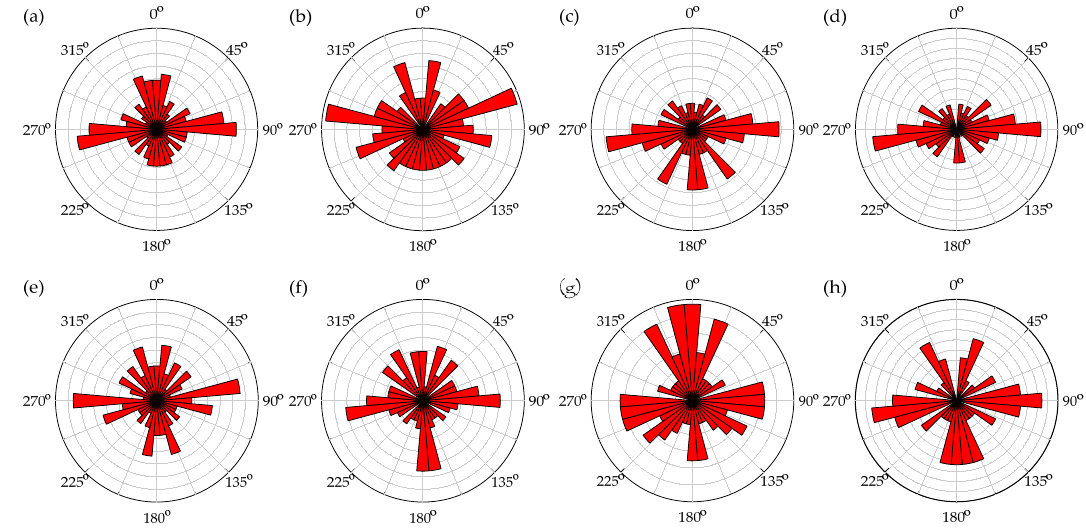
Figure 12. Nightingale rose chart of S2 after (a) 0, (b) 1, (c) 2, (d) 3, (e) 4, (f) 5, (g) 6, and (h) 8 F-T cycles.